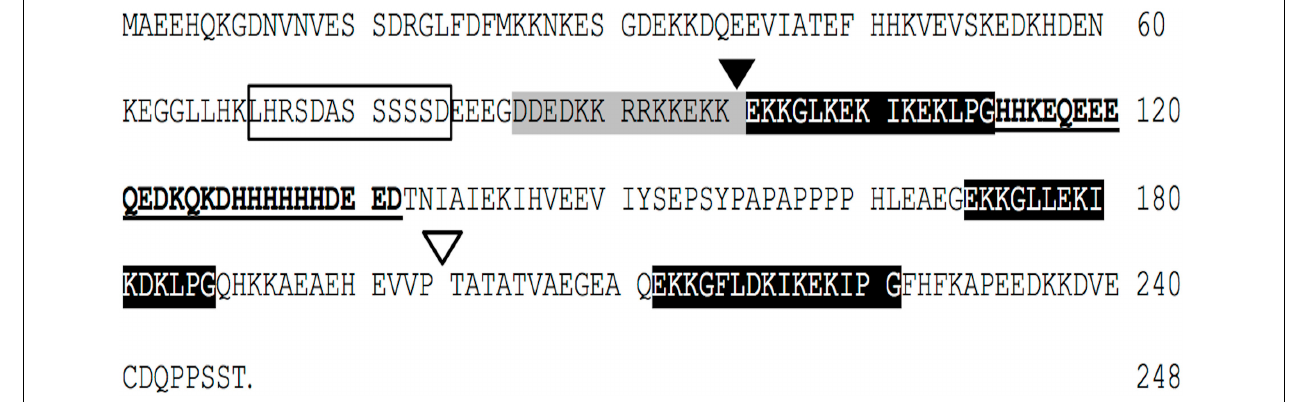
FIGURE 1 | The Opuntia streptacantha DHN (OpsDHN1) amino acid sequence, and schematic representation of characteristic motifs present in OpsDHN1 protein: S-segment (open box), poly-lysine rich sequence